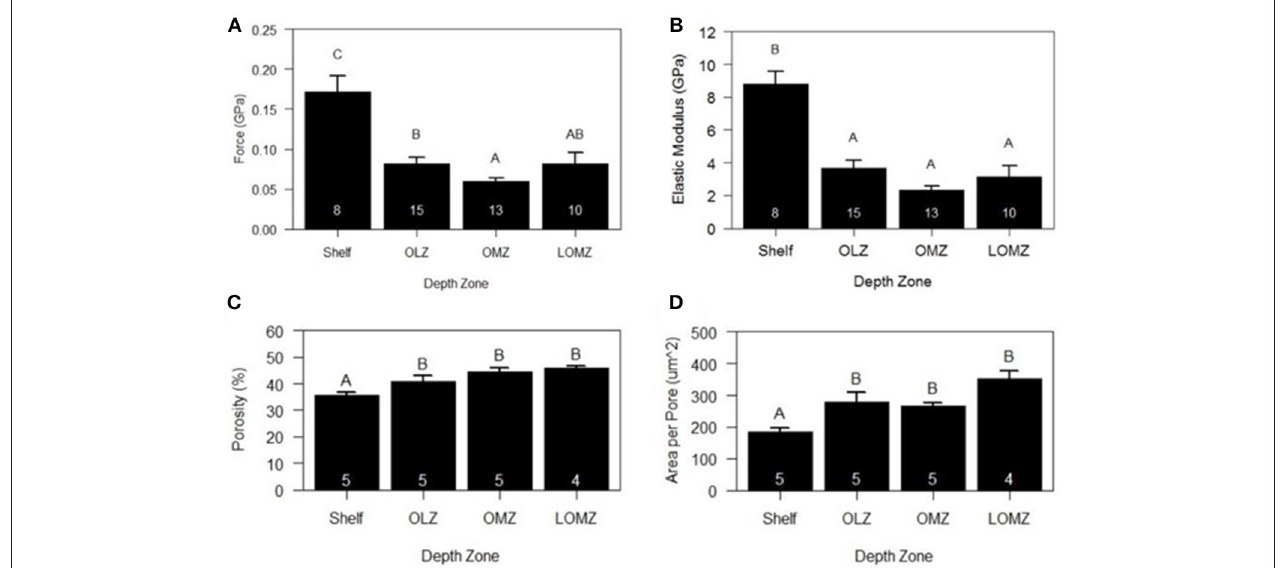
FIGURE 5 | Mean biomechanical and material properties of Strongylocentrotus fragilis across depth zones. (A) Hardness (GPa). (B) Stiffness (i.e., Elastic Modulus). (C) % Porosity. (D) Area per pore ( µ m 2 ). White numbers inside bars indicate number of individual urchin replicates. Errors bars indicate + 1 standard error. Shelf = < 200m; OLZ = Oxygen Limited Zone (22–60 µ mol oxygen kg − 1 ); OMZ = Oxygen Minimum Zone core ( < 22 µ mol oxygen kg − 1 ); LOMZ = Lower Oxygen Minimum Zone ( > 900m where dissolved oxygen begins to